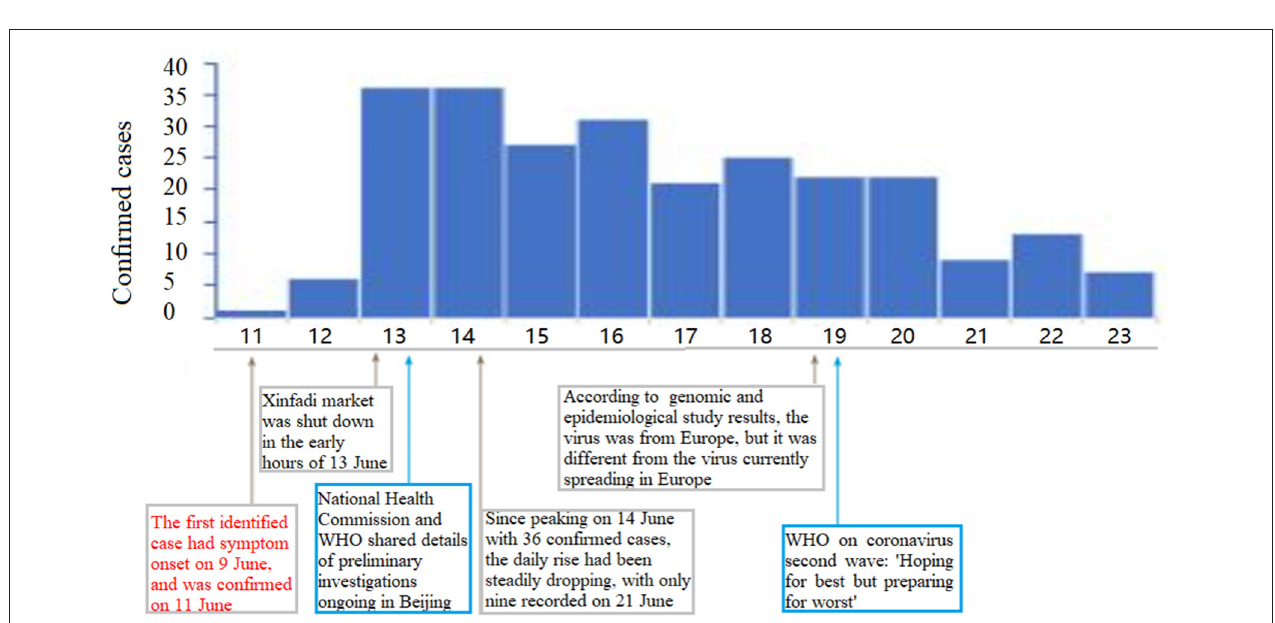
Frontiers in Medicine |